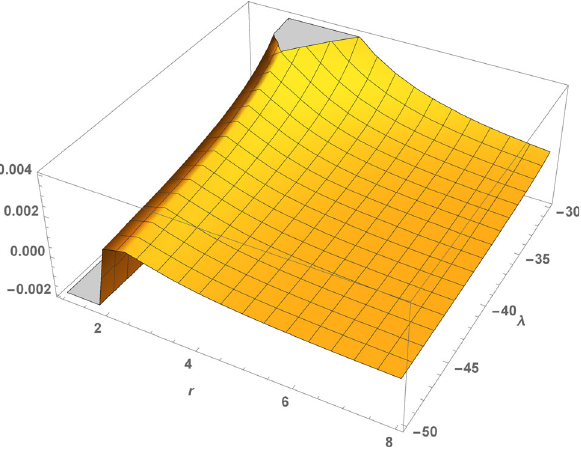
Fig. 9 Violation of DEC, ρ ≥ | p r | , for α = 5 and different λ